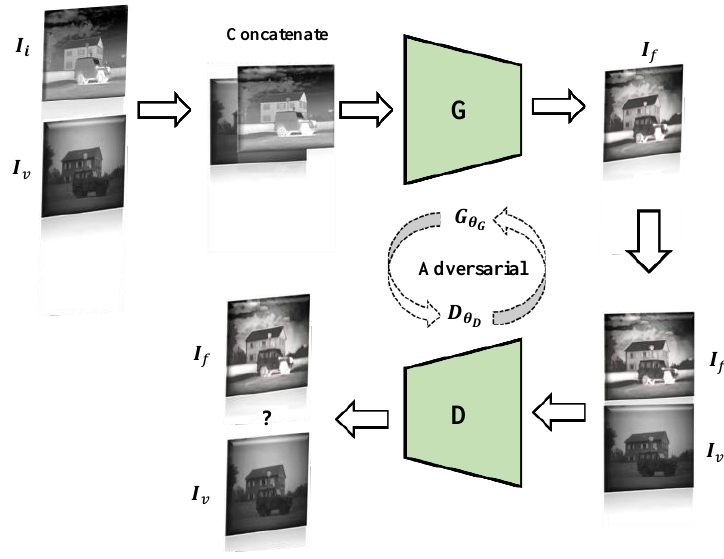
Figure 4. GAN-based infrared and visible image fusion framework.